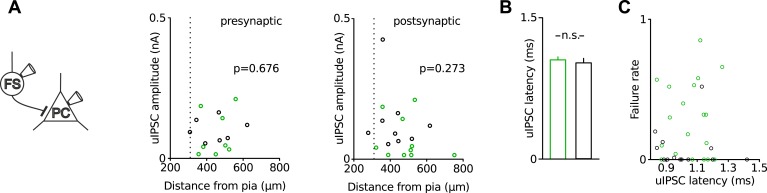
Recording depths and axonal distance between pairs of synaptically connected neurons are similar in Disc1 and control FS-IN to PC recordings.(A) Amplitude of uIPSCs is plotted against distance of the recorded soma from the pial surface. Broken line indicates border between layer 2/3 and 5. There is no correlation between uIPSC amplitude and the anatomical depth of the presynaptic (left) or postsynaptic (right) neuron in FS-IN to PC paired recordings in acute prefrontal slices. (B) Synaptic latency was defined as the time between the maximal point of rise of the presynaptic action potential and the onset of the postsynaptic uIPSC. Paired recordings in Disc1 and control slices show similar mean synaptic latencies (Disc1: 1.0 ± 0.03 ms vs control 1.0 ± 0.05 ms, p = 0.379, n = 19 Disc1, 13 control pairs), suggesting similar axonal distance between pre- and postsynaptic partners under the assumption of similar conduction velocities of action potentials and similar transmitter release periods. (C) Failure rate did not depend on the distance (expressed as synaptic latency) between pre- and postsynaptic cells (r = −0.04, p = 0.825). Bars represent mean ± SEM, circles represent individual data points.